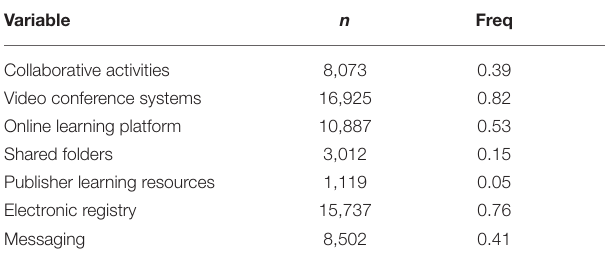
TABLE 2 | Frequencies of technologies adoption during ERE.